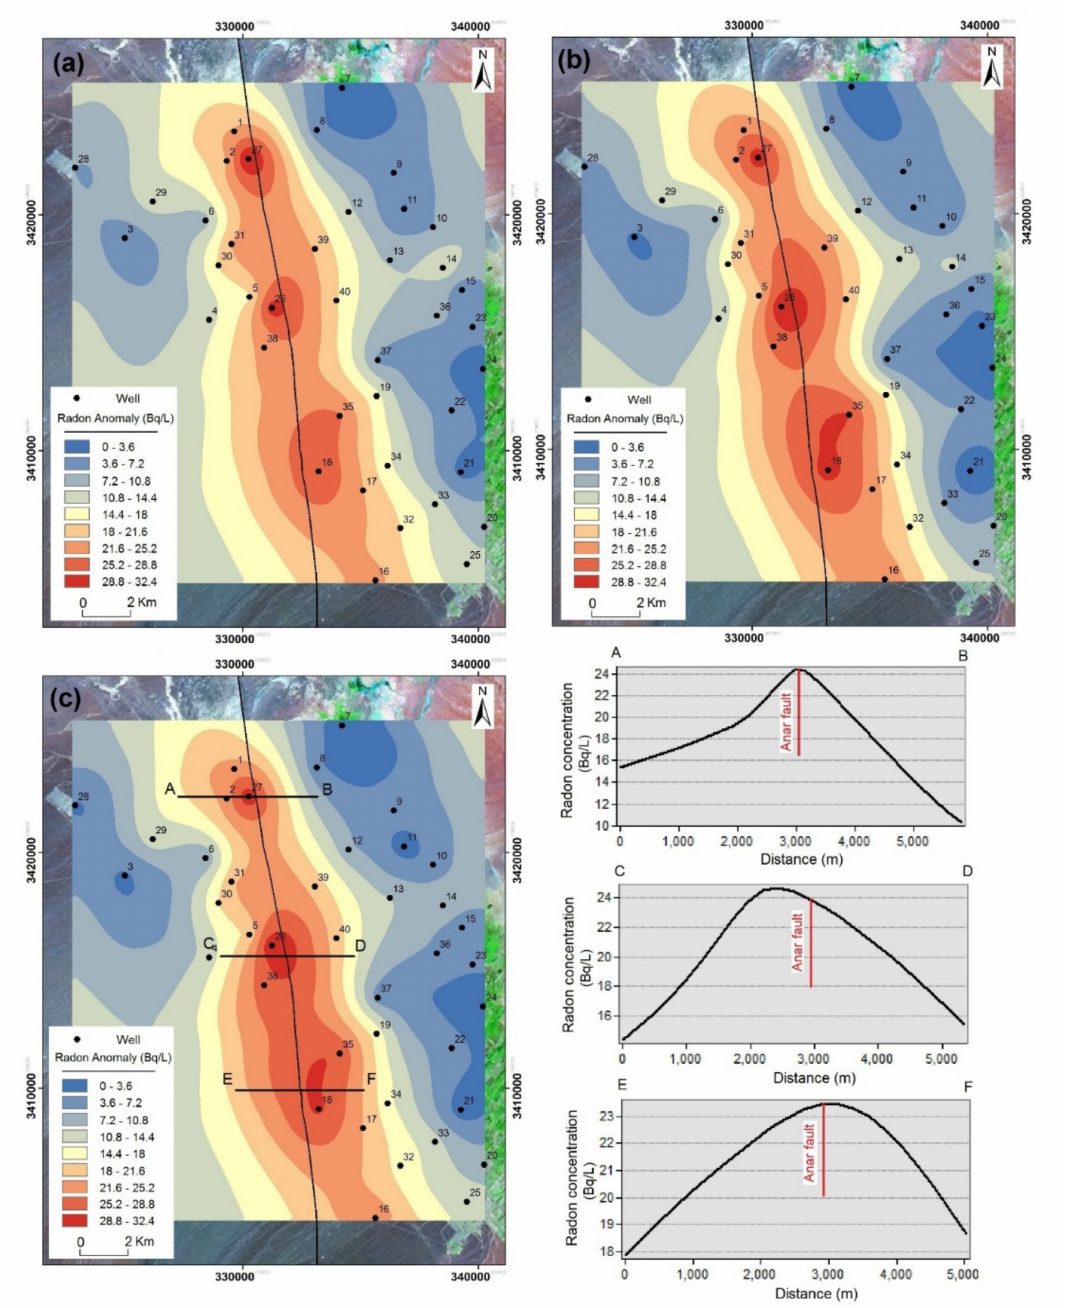
Figure 12. Classified map of radon anomaly in the study area: ( a ) 2018, ( b ) 2019, and ( c ) 2020. Bottom right figure shows radon anomaly profile AB, CD, and